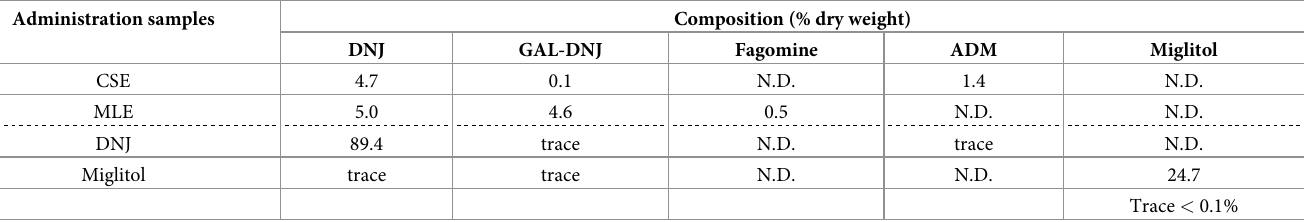
Table 1. The aza-sugars composition of administration samples. Administration